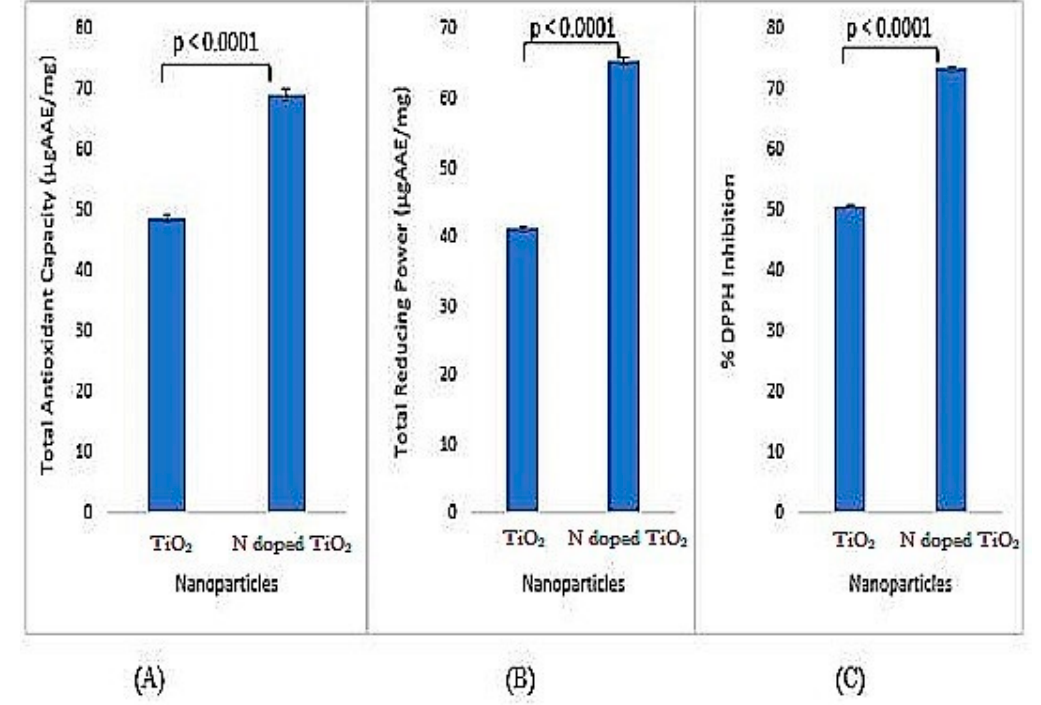
Figure 10. Antioxidant activity ( A ) total antioxidant capacity, ( B ) total reducing power, and ( C ) % DPPH inhibition exhibited by TiO 2 nanoparticles and N-doped TiO 2 nanoparticles. Error bars are shown as standard deviation on each bar. Bars are significantly different at confidence interval level of 95%.